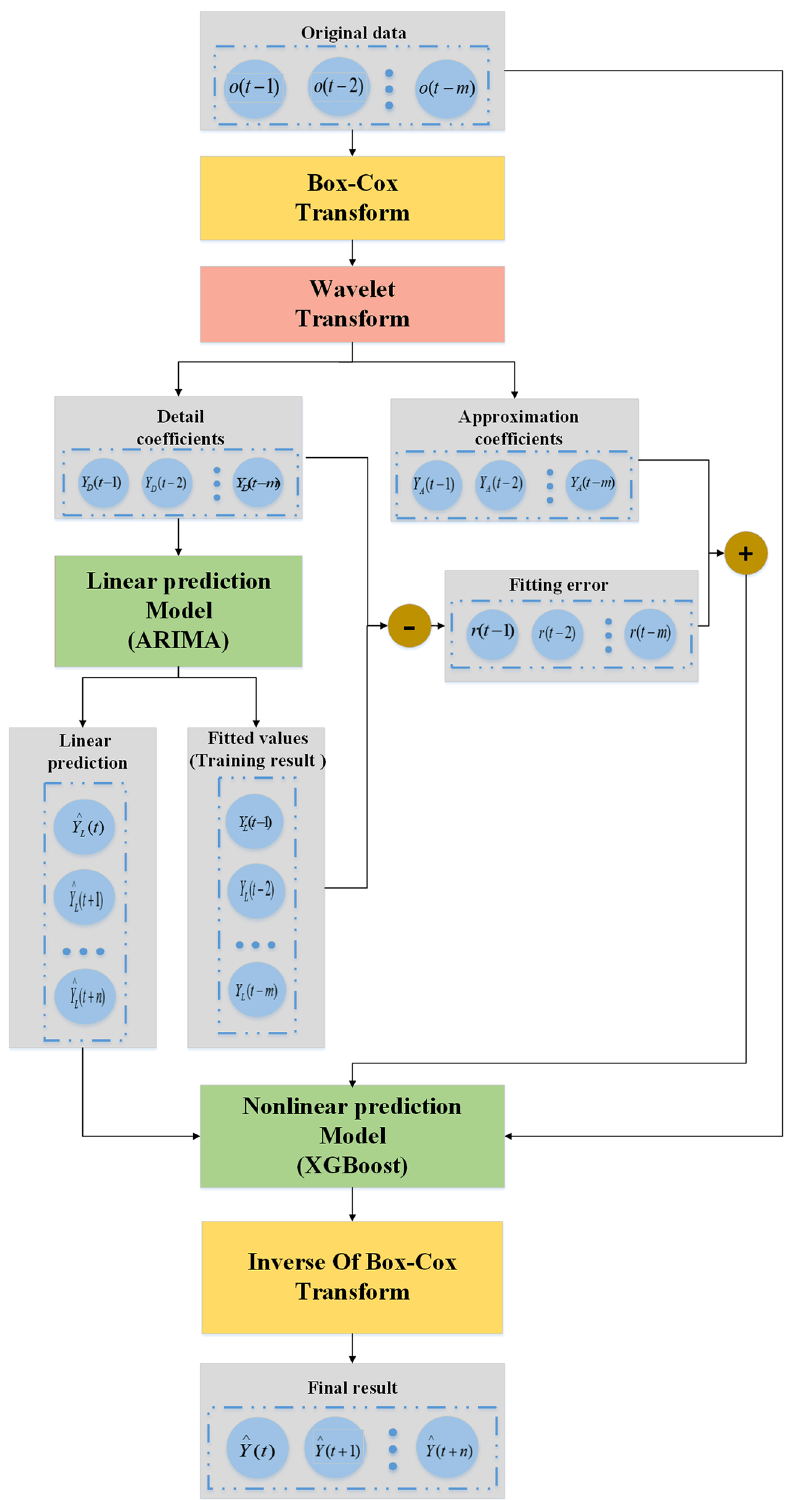
Fig. 3 The framework of WT-ARIMA-XGBoost hybrid prediction